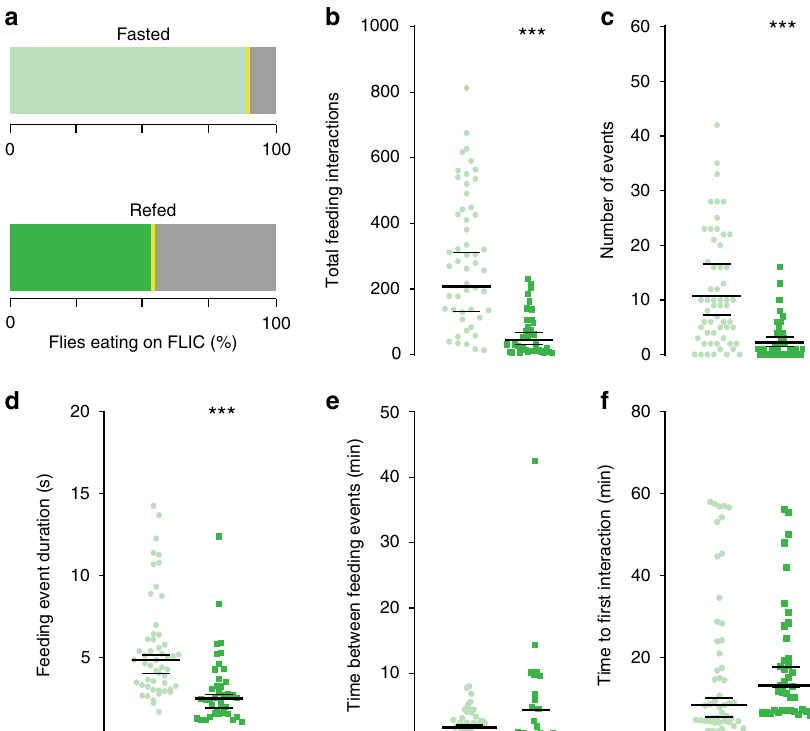
Fig. 1 The feeding behaviors of fasted and refed fl ies. The feeding behavior of 24 h-fasted (light green, circles) and previously refed (darker green, squares) fl ies during ad-lib access to 5% sucrose on the FLIC for 1 h (See Supplementary Fig. 1 for a schematic). Individual data points are plotted in all cases. For panels b , c , which were analyzed using a Bayesian model (see Methods for details), bars show the average fi tted value and the extent of a 95% credible interval; three asterisks indicate that the posterior probability from Bayesian analysis of a difference in the observed direction is greater than 0.999. For panels d – f plotted bars show a bootstrap-based median and extent of a 95% con fi dence interval; *** p < 0.001 using a strati fi ed bootstrap. Fasted n = 48, refed n = 38 biologically independent animals. Source data are provided as a Source Data fi le. See Methods for a detailed description of the behavioral quanti fi cation and analysis. a The percentage of fasted and refed fl ies that interacted with food on the FLIC (green shades), compared to those that did not eat (gray shades). b – f The feeding behavior of fl ies during the 1-h ad-lib access to 5% sucrose quanti fi ed as b the total number of feeding interactions; c the number of feeding events (de fi ned as fi ve of more consecutive feeding interactions above threshold); d the mean duration (sec) among feeding events; e the mean time between 2 or more feeding events (min); f the latency to interact with food (min), calculated as the fi rst feeding interaction initiated on the FLIC. For panels d – f , replicates with no feeding events were excluded (for panels b , c the no-interaction events are explicitly accounted for in our zero- in fl ated negative binomial model). Source data are provided as a Source Data fi metabolic pathway database with gene annotations collected from Flybase 24 . The Flyscape database contains 4856 metabolites, 2326 enzymes, 15,577 genes, and 2827 reactions. Flyscape can generate four types of network graphs with varying complexity: compound networks where compounds are represented as nodes and reac- tions are represented as edges (Supplementary Fig. 3b), compound-reaction (Supplementary Fig. 3c), compound-gene (Supplementary Fig. 3d), and compound-reaction-enzyme-gene networks (Supplementary Fig. 3e). In the last three types of networks the respective entities are represented as nodes. Notably, in all types of networks each node is unique and nodes from different pathways can be connected. Further, the networks can be re fi ned by creating subnetworks based on pathways or com- pounds of interest. This feature allows visualization of changes across different pathways and conditions in a simple, intuitive way. In addition, Flyscape integrates metabolomics data with other types of omics data to build a network of the physiological landscape of the tissue or cell under different conditions. Bodies and heads show unique metabolic shifts . We analyzed the metabolic pro fi les of the bodies and heads of refed and fasted fl ies. PCA showed that the variance between these two datasets was largely due to the feeding state (Supplementary Fig. 4a, b). In